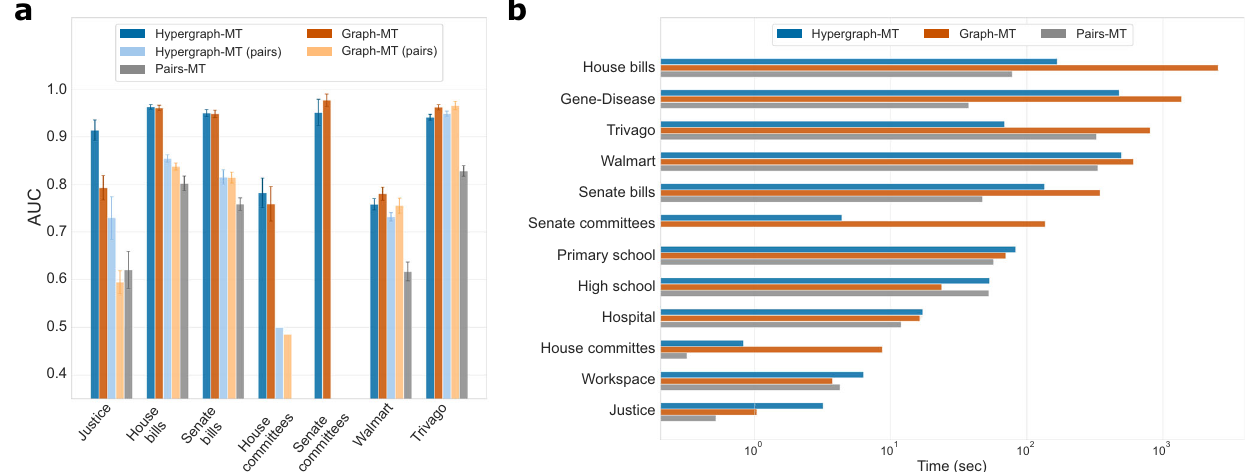
Fig. 4 | Hyperedge prediction performance and computational complexity in higher-order datasets. a The performance of hyperedge prediction is measured withtheAUC,whosebaselineistherandomvalue0.5.Theresultsareaveragesand standard deviations over 5-fold cross-validation test sets. For each dataset, we run the model on the hypergraphs (Hypergraph-MT), the graphs obtained by clique expansions (Graph-MT), and the graphs given only by the registered pairwise